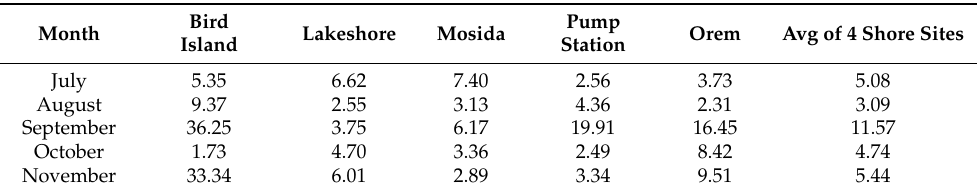
Table 4. Monthly TP deposition data comparing results from the lake interior sampling location (Bird Island) to data from lake shore sample locations. Except for October, Bird Island, the lake interior site, had higher AD rates than the average of the four shoreline sites. All data represent deposition rates in mg/m 2 /month.